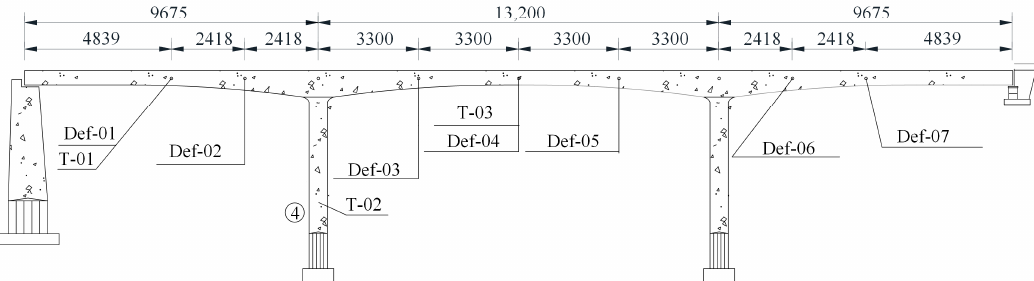
Figure 15. Longitudinal section layout of the bridge sensors/cm.